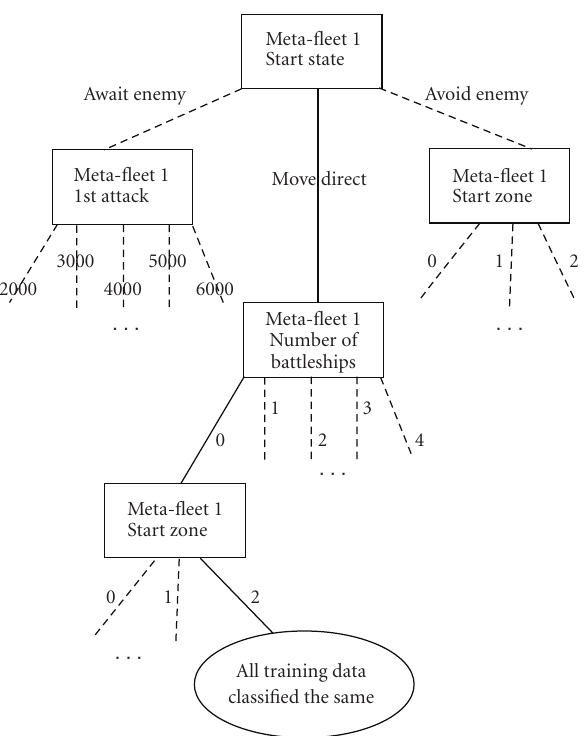
Figure 7: Full selected path through the decision tree. Chosen path is highlighted in bold, not chosen branches are truncated. Remaining plan items are filled in randomly, in this case this is second large-scale movement, first attack time, and number of carriers in